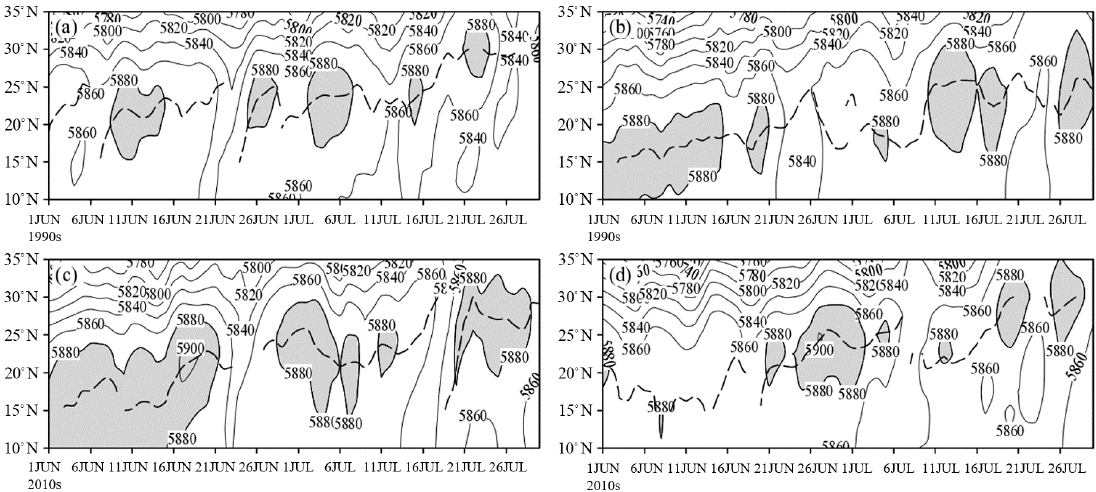
Figure 5. Time-latitude profile of 500-hPa mean geopotential height at 110~130 ° E (the solid line denotes geopotential height, unit: gpm; the shaded areas denotes geopotential height exceeding 5880 gpm) and western Pacific subtropical high ridgeline (dashed line) from June to July of early-arriving Meiyu in the 1990s ( a ), late-arriving Meiyu in the 1990s ( b ), early-arriving Meiyu in the 2010s ( c ), and late-arriving Meiyu in the 2010s ( d ).